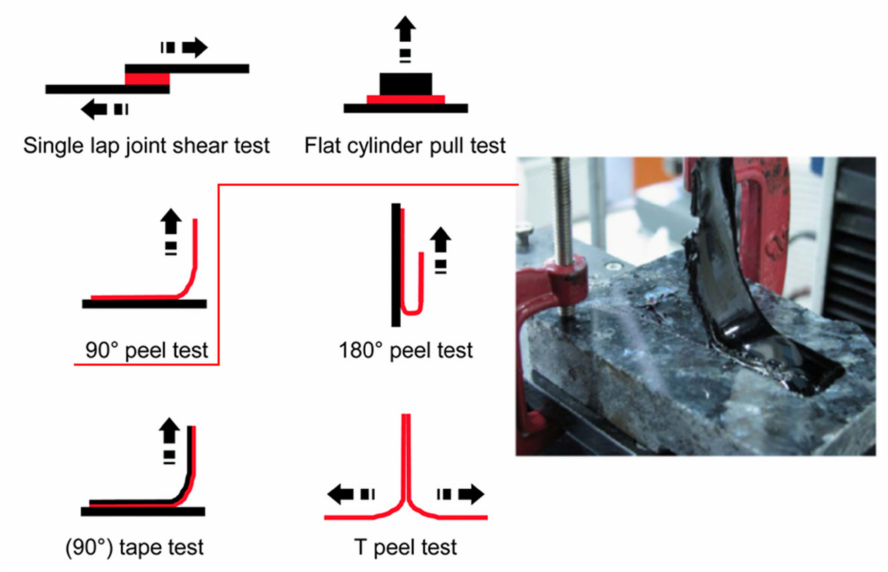
Figure 3. Possible schemes on peel